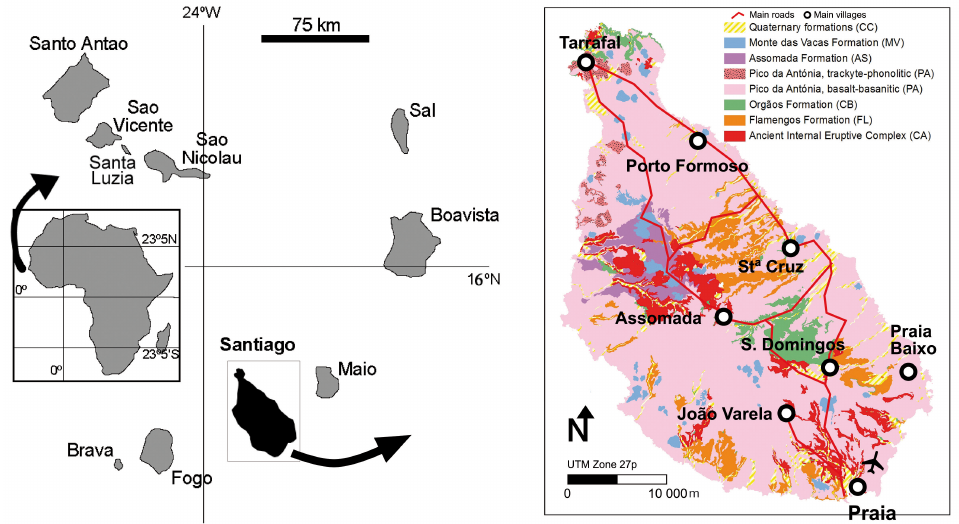
Figure 1. The Cape Verde Archipelago and its location in Africa’s western coast and Geological cartography of Santiago Island, Cape Verde, modified from